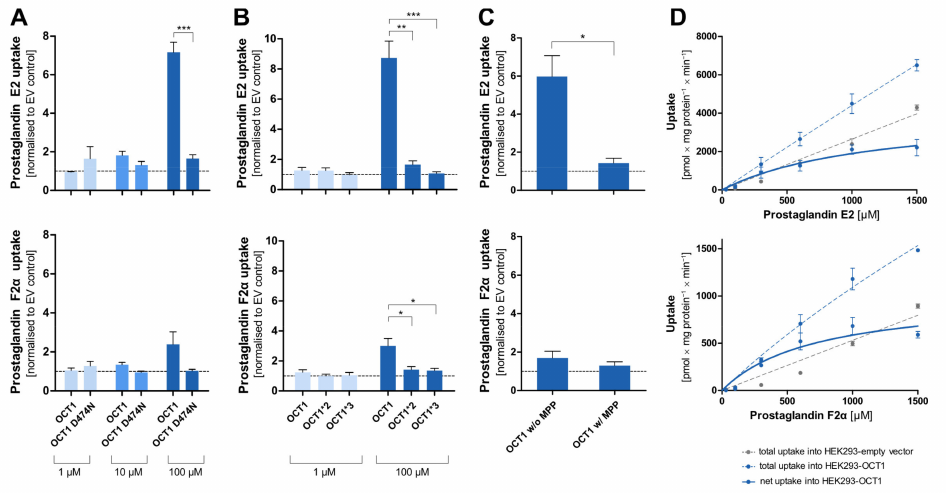
Figure 8. Cellular uptake of prostaglandins by OCT1. Cellular uptake ratios were determined in HEK293 cells that were transfected stably with OCT1 or its variants that were incubated with 1 µ M (light blue), 10 µ M (medium blue), and 100 µ M (dark blue) of prostaglandin E2 and F2 α for 120 s. Thus, four separate sets of experiments confirmed the carrier-mediated transport of PGE2, and three separate sets of experiments confirmed carrier-mediated transport of PGF2 α . ( A ). Uptake ratio by variant OCT1 D474N in comparison to OCT1 wild-type. ( B ). Uptake ratio by natural variants OCT1*2 (M420del) and OCT1*3 (R61C) in comparison to the wild-type. ( C ). Uptake ratio of OCT1 wild-type without and with the inhibitor MPP + (1 mM inhibitor, 100 µ M prostaglandin). ( D ). Concentration-dependent total uptake by OCT1 WT (dotted blue curve) and empty vector (dotted grey curve) as well as the resulting net uptake (straight blue curve). The uptake by the transporters was normalised to the uptake by the empty vector. The experiments were conducted at least three times (n ≥ 3) independently with both prostaglandins. Statistical significance of the uptake ratio between OCT1 and its variants and between inhibited and not inhibited OCT1 was determined using an unpaired students t -test with * p < 0.05, ** p < 0.01, and *** p <